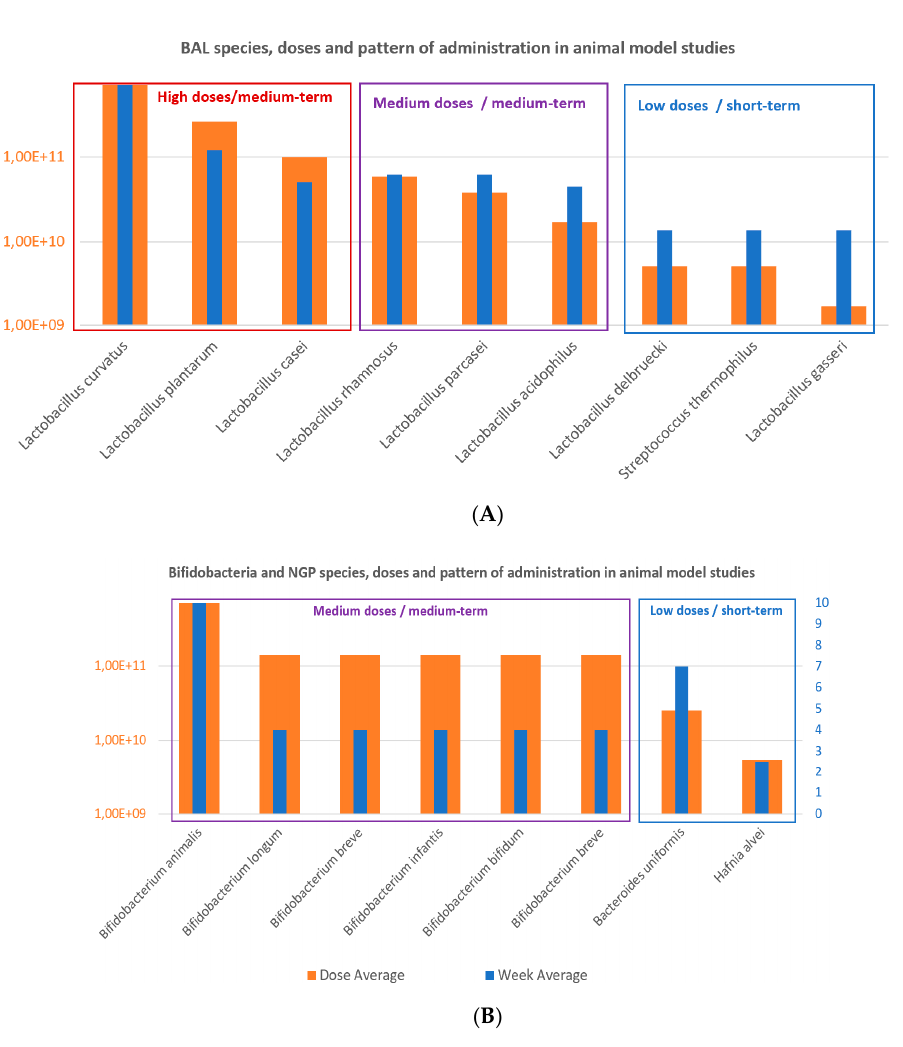
Figure 4. ( A ) Lactobacillus and LAB species and ( B ) Bifidobacterium and next-generation probiotics (NGP) species used in obesity-related disorders from selected animal clinical studies.